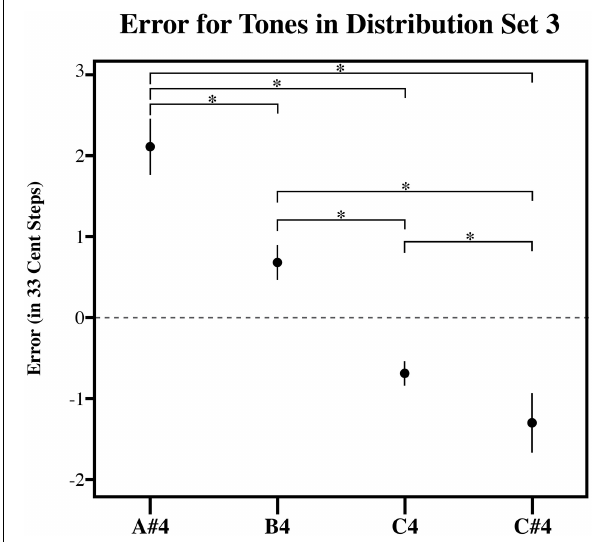
FIGURE 5 | The plot of the estimation error in 33-cent steps for each tone in Distribution Set 3. Significant pairwise comparisons (alpha 0.05) using a Sidak adjustment are indicated with an asterisk. Note that while individuals bisected the presented distribution at its midpoint, such that lower target tones in the series are overestimated and higher target tones in the series are underestimated similar to the randomly generated tone estimate data, individuals produced estimates that were significantly more accurate than the RGD ( Figure 6C ). Error bars represent ± 1 s.e.m.